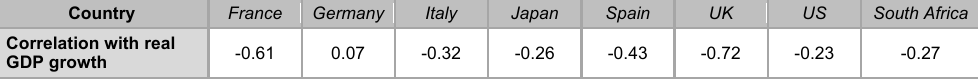
Correlation of the credit-to-GDP gap with GDP growth around the globe Country Correlation with real GDP growth